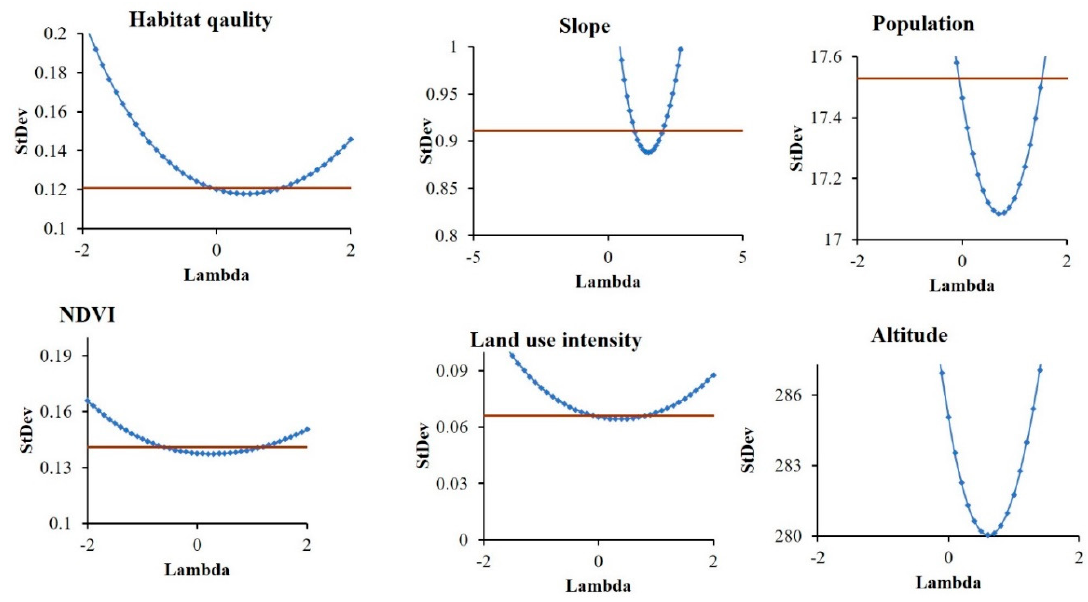
Figure 13. Box-Cox power transformation of habitat quality impact factors.